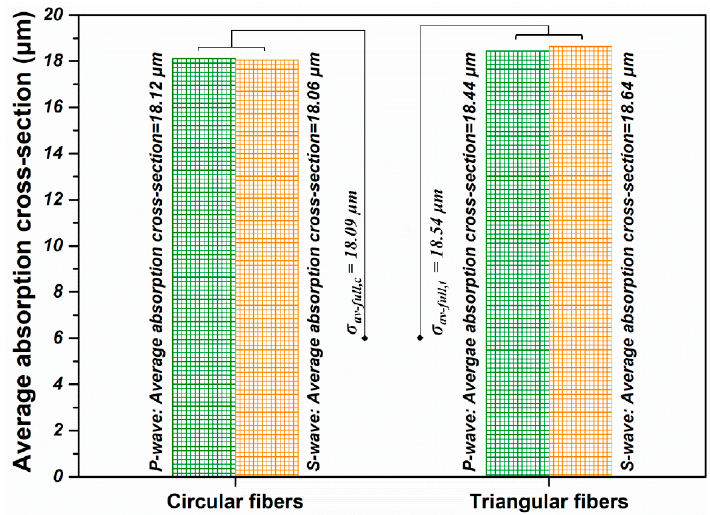
Figure 8. The comparison of average absorption cross-section between the circular and triangular fibers, with the fully-random arrangement.